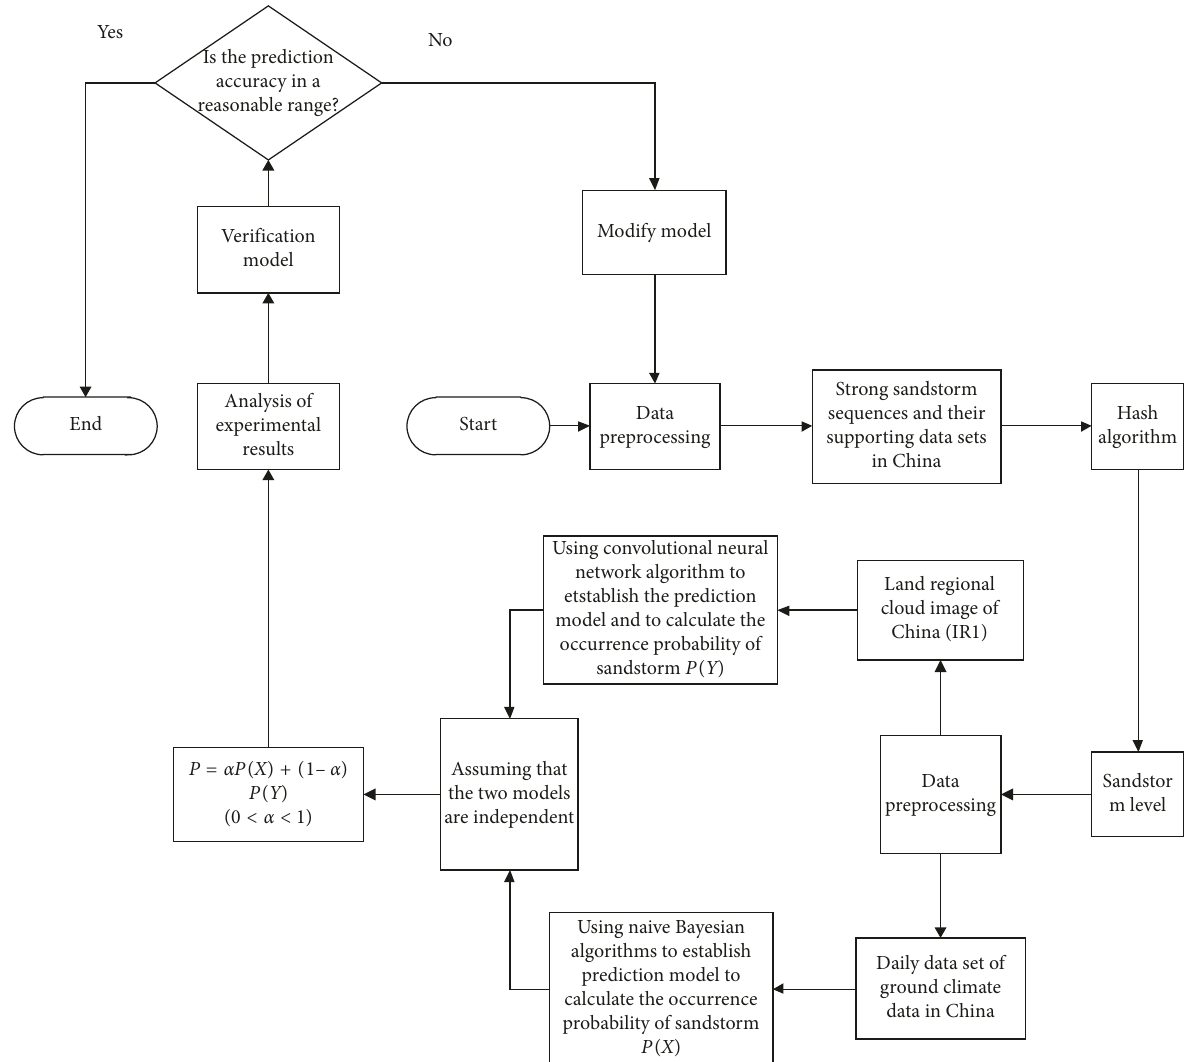
Figure 8: Training process of naive Bayesian-CNN classification